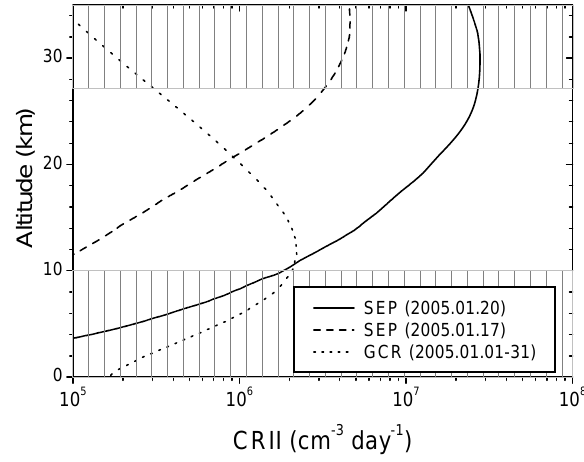
Fig. 1. Daily integrated cosmic ray induced ionization (CRII) of the polar atmosphere in January 2005. Solid and dashed curves depict the net ionization due to two SEP events, of 20 January and 17 January (a typical event), respectively. The dotted curve depicts the average ionization rate due to galactic cosmic rays in January